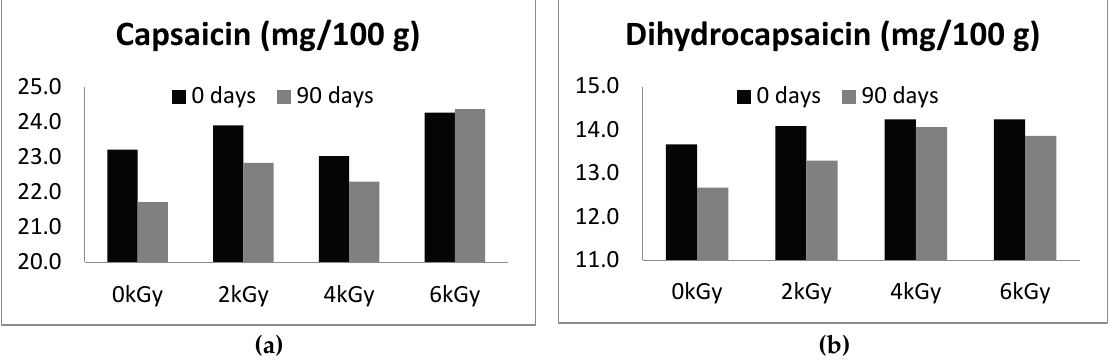
Figure 1. Effect of gamma radiation on ( a ) capsaicin and ( b ) dihydrocapsaicin concentrations in hot peppers during three months’ storage.